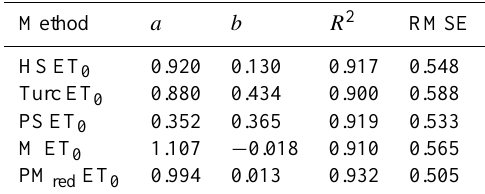
Table 3. Calibration and performance of the five tested ET 0 meth- ods, in relation to the FAO-56 PM ET 0 standard (Penman–Monteith method defined in the FAO-56 paper). All the ET 0 methods are de- tailed in Appendix A. a , b and R 2 are the results of linear regression between FAO-56 PM ET 0 and tested ET 0 methods. RMSE is the root mean square